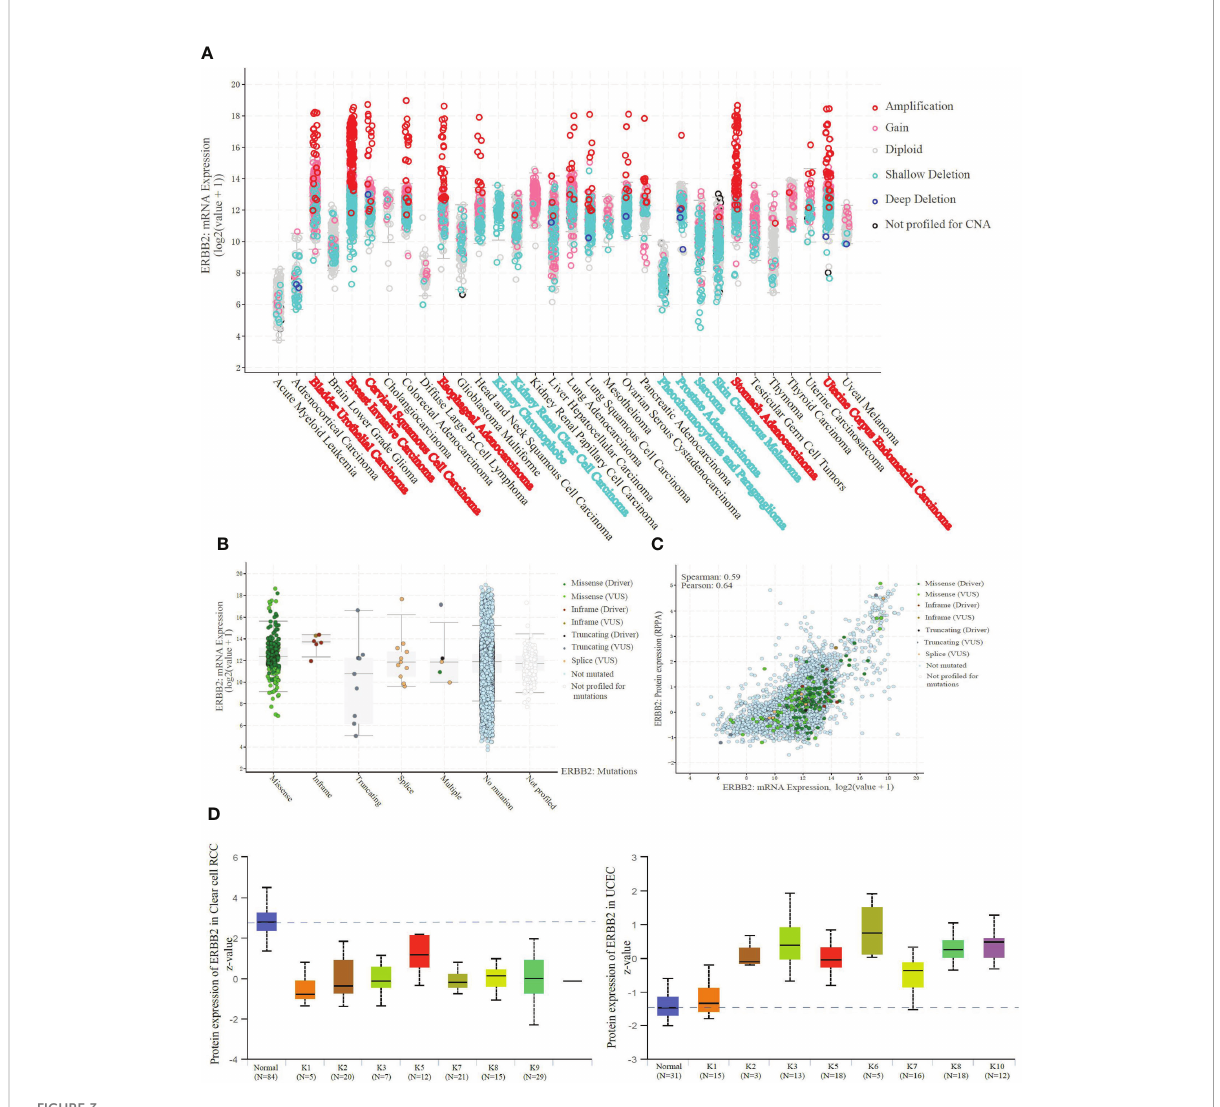
FIGURE 3 ERBB2 demethylation results in the ampli fi cation of mRNA and protein. (A) Ampli fi cation indicates a high-level ampli fi cation (more copies, often focal), and it shows a low-level gain function(a few additional ampli fi cation, often broad). Deep deletion indicates a deep loss, possibly a homozygous deletion, and shallow deletion indicates a shallow loss, literally a heterozygous deletion in the pan-cancer analysis. BRCA, STAD, UCEC, BLCA, ESCA, and CESC show speci fi c ampli fi cation in the ERBB2 transcription level. And KICH, KIRC, PRAD, SARC, and SKCM present shallow deletion, possibly a heterozygous deletion. (B) ERBB2 mRNA expression of 10967 samples from 32 studies was sorted in the available parameters, according to ERBB2 missense, in-frame, truncating, splice, multiple, no mutation, and no pro fi led. ERBB2 missense is a dominant factor resulting in mRNA ampli fi cation. (C) Correlation analysis of ERBB2 mRNA expression and protein translation. There is no relationship between ERBB2 mRNA missense or ampli fi cation and protein level in the samples. (D) Unsupervised clusteringanalysis was performed using the ERBB2 proteins from the CPTAC Con fi rmatory/Discovery total protein data set across fi ve CPTAC projects. The Mass-spectrometry-based proteomic data to categorize 109 cases into nine different KIRC subtypes. Z-values represent standard deviations from the median score across samples for the given cancer type. ERBB2 protein of K1-K9 subtypes in KIRC displayed a de fi ciency compared to the normal tissues. Moreover, ERBB2 protein of K1-K10 subtypes in 100 cases of UCEC was performed to be raised compared to the normal tissues, using log-transformed expression values centered on standard deviations from the median